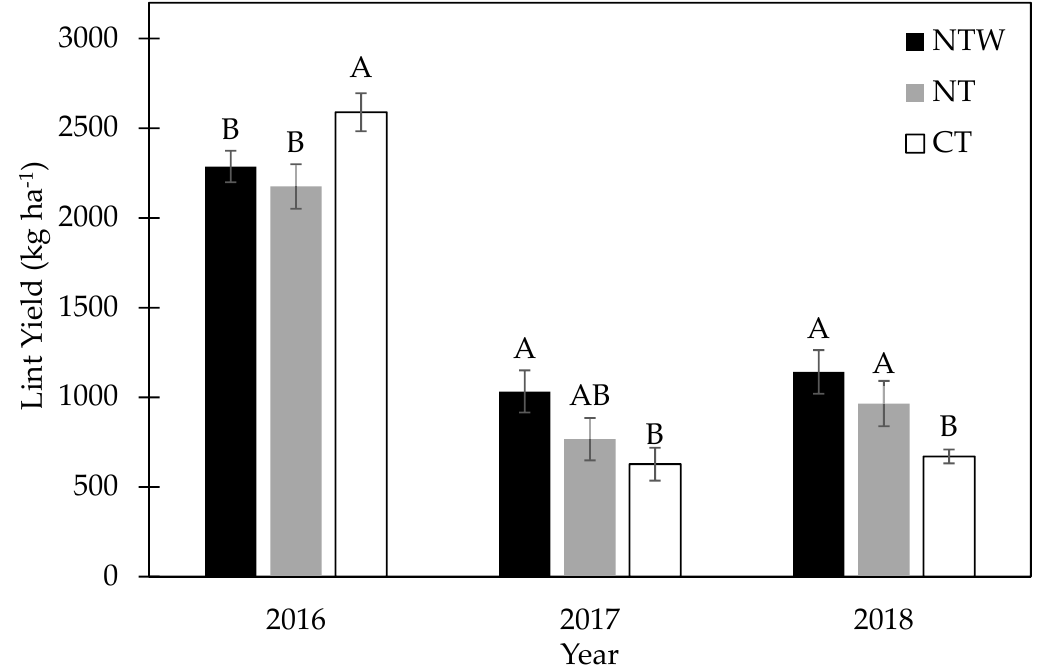
Figure 2. Lint Yield in 2016, 2017, and 2018. NTW, no-till with winter wheat cover; NT, no-till winter fallow; CT, conventional tillage winter fallow. Bars are standard error of the mean. Tillage means within year with the same letter are not different ( α = 0.05).